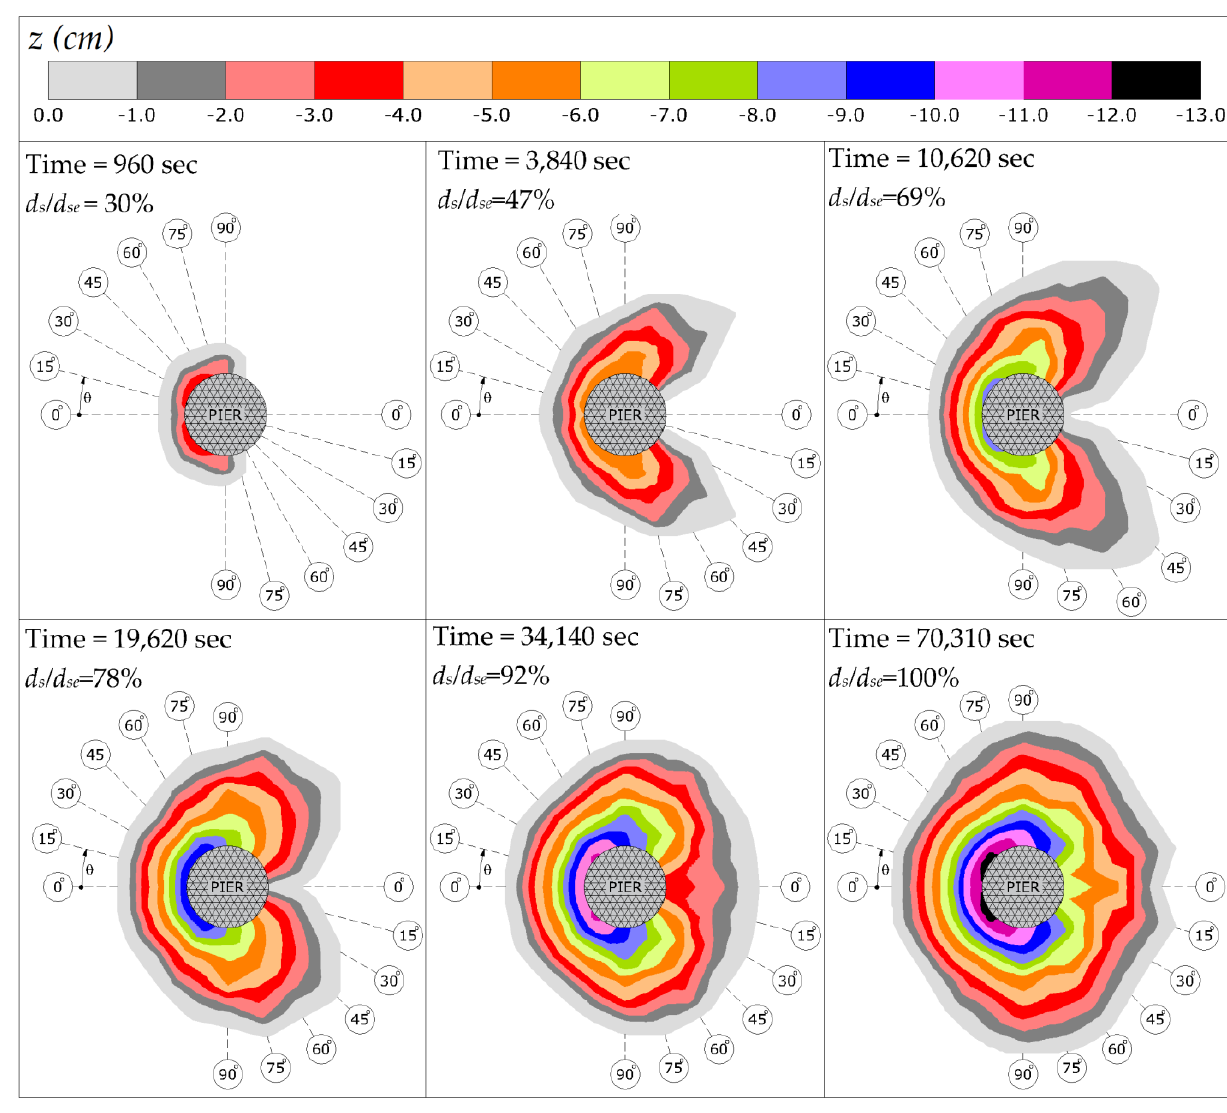
Figure 1. Scour hole development, adapted from [46].